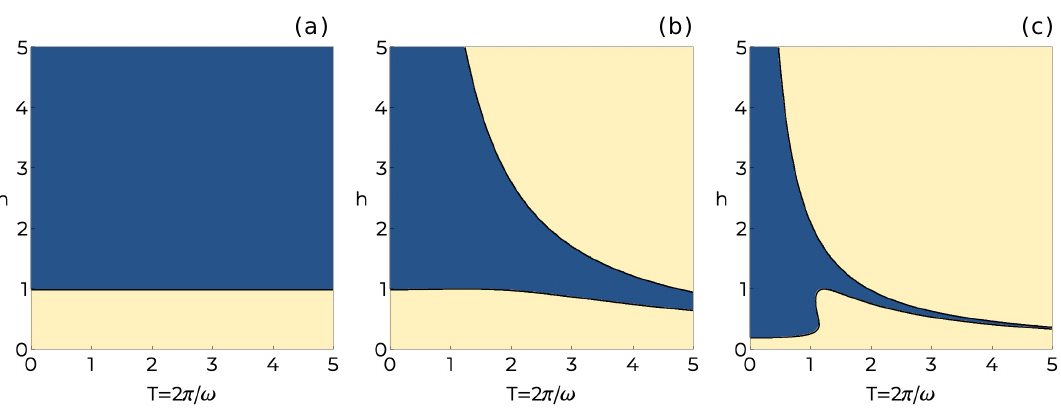
Figure 1: Number of solutions for d ε ( k ) / dk = 0 in k ∈ ( 0, π ) obtained by the HF expansion. The blue (yellow) region represents the number 0 (1). The zeroth-order (a) and second-order (b) calculation for g = 0.1. (c) The second-order calculation for g =